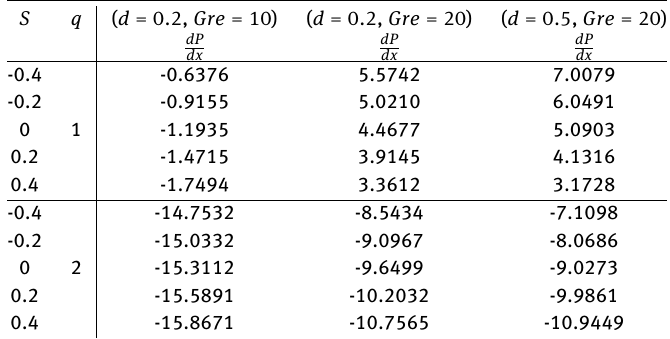
) for different values of S , q , d and Gre where λ = −0.3 , ε = −0.3 , Br = 0.2 dx